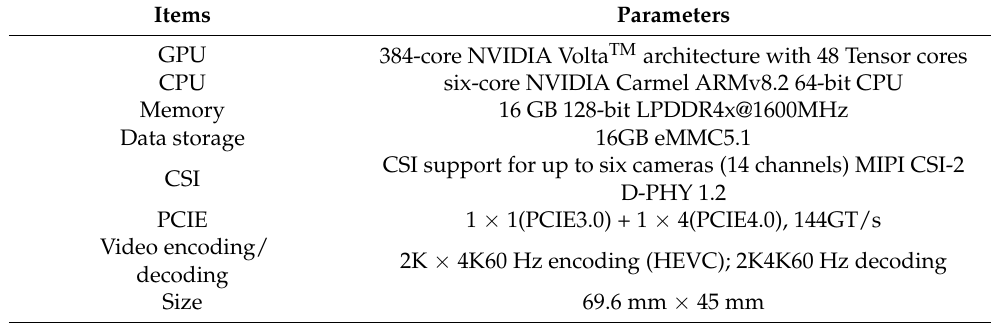
Table 1. Parameters of Jetson Xavier NX.